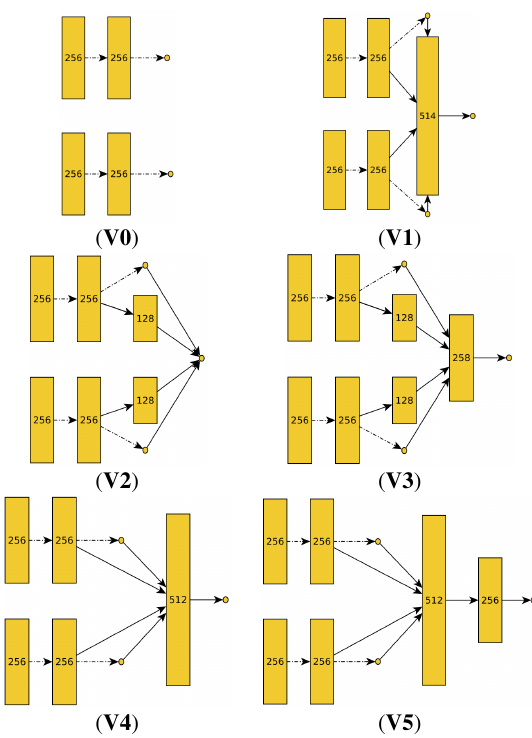
Figure 5. Combined neural network architecutres using an MLP-like head. ( V0 ) Initial W-DSPEB and C-DSPEB output layers. ( V1–V5 ) Candidate combination schemes forming a multi-input, single-output neural architecture (H-DSPEB). Dotted connections represent connections with pre-trained Figure 4. Training of the W-DSPEB and C-DSPEB models, weights from C-DSPEB or W-DSPEB. The numbers represent showing the MSE losses over the training and validation sets in the size of the latent feature space at each layer. French Guiana. Dashed lines represent performance on the validation set.